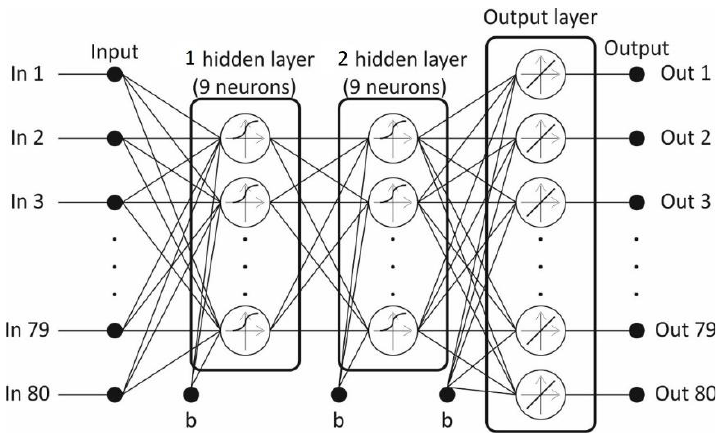
Figure 12. The structure of a neural network.